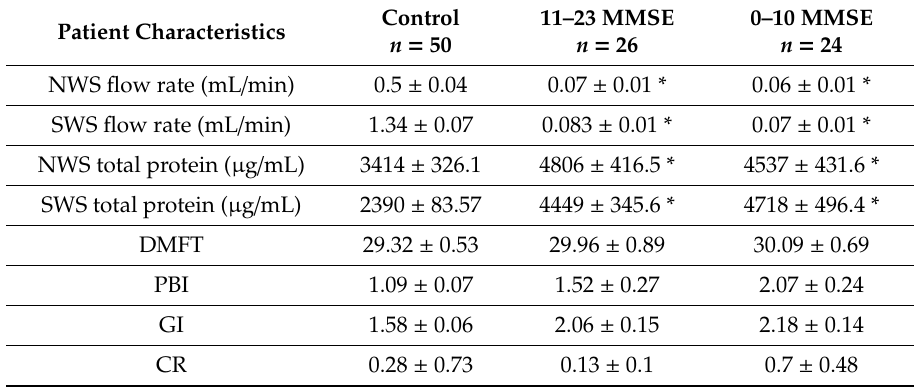
Table 3. Salivary gland function and stomatological characteristics of dementia patients and control